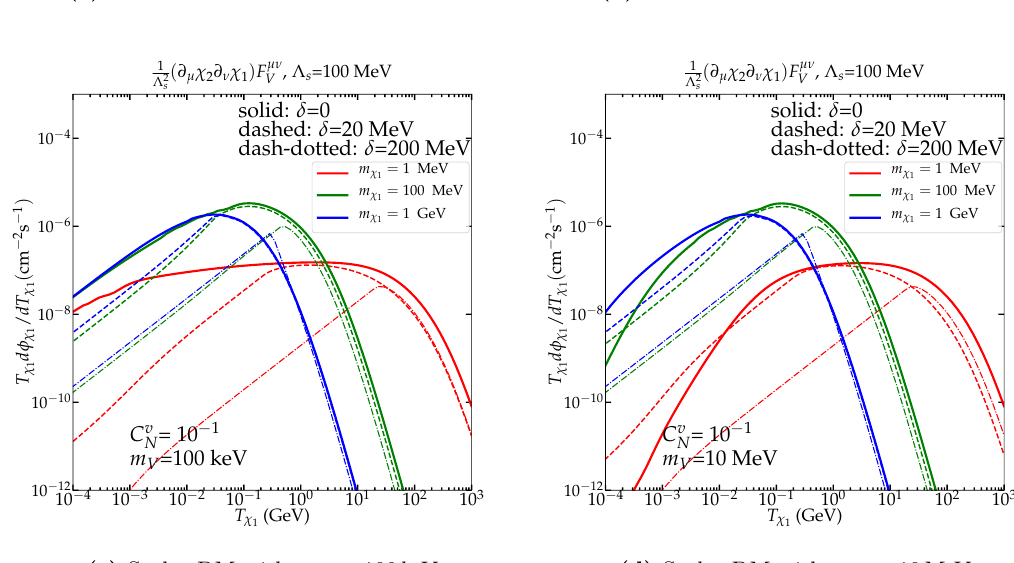
Figure 7. Energy spectra of CRDM for L f masses applied here are m scheme is the same as figure